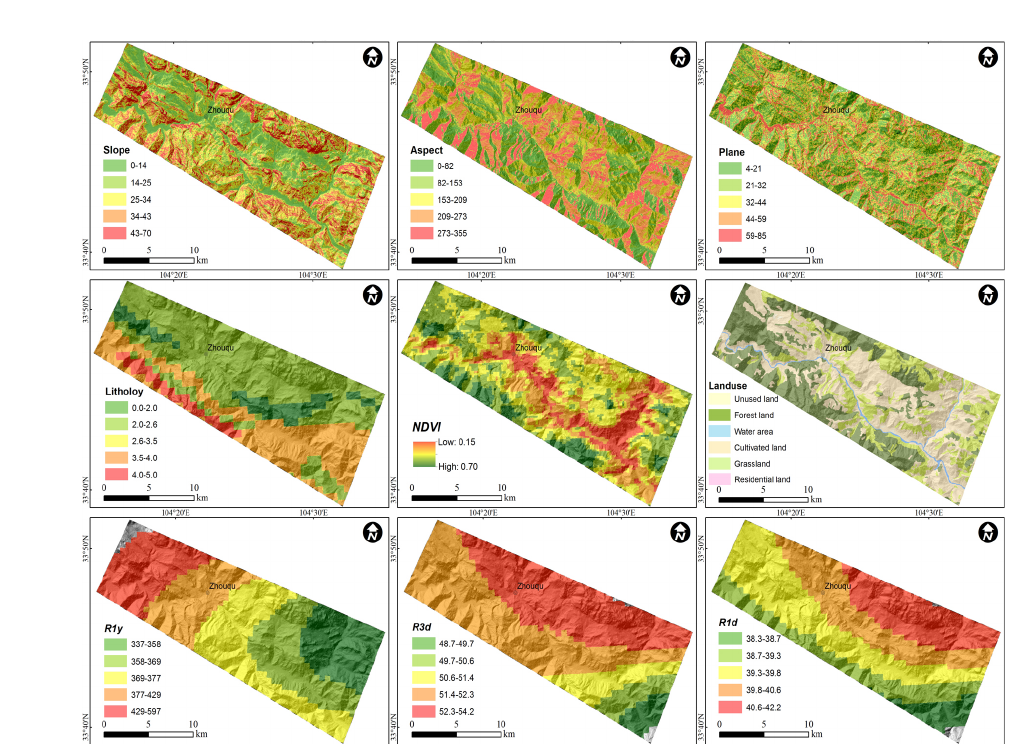
Figure 3. Spatial distribution of some major